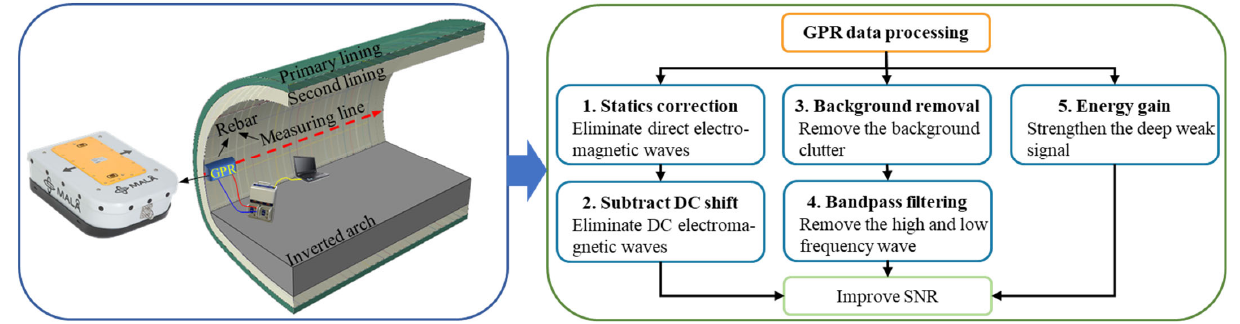
Figure 4. MALA GPR system with 500 MHz for tunnel side wall detection. The SNR was improved by five steps of data progress.